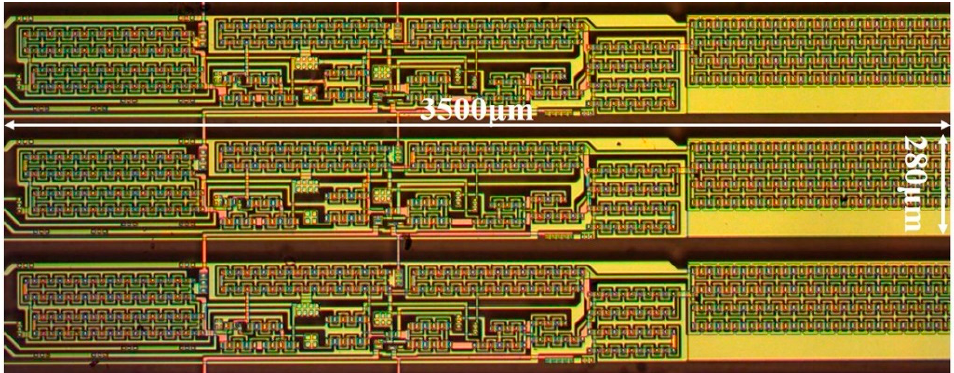
Figure 7. The optical microscope of the proposed SR circuits.